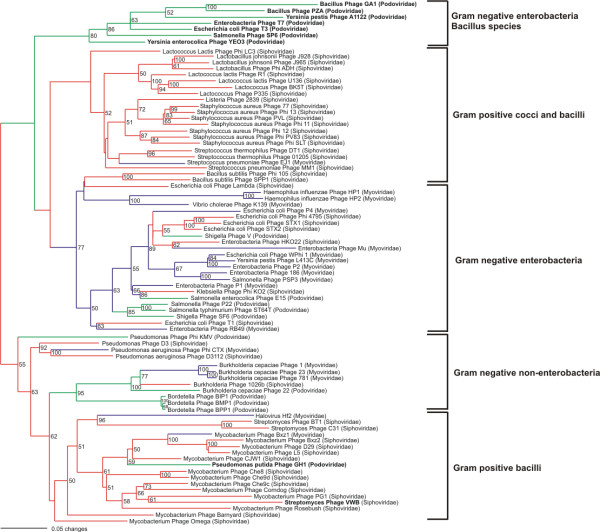
Phylogram of 83 selected bacteriophages for which genomic sequences are available. The organisms were grouped by using distance matrices based on the sums of the differences from the other organisms for the 256 tetranucleotide combinations, as described in Materials and Methods. Phylogenies were created by neighbor-joining analysis. Colors indicate Myoviridae (contractile tails; blue), Podoviridae (short tail stubs; green), and Siphoviridae (long tails; red). Bootstrap values >50 based on 100 replicates are represented at each node, and the branch length index is indicated below the phylogeny. Bacteriophage source by host species – gram-positive bacilli, gram-positive cocci, gram-negative enterobacteria, and gram-negative non-enterobacteria are indicated by brackets.